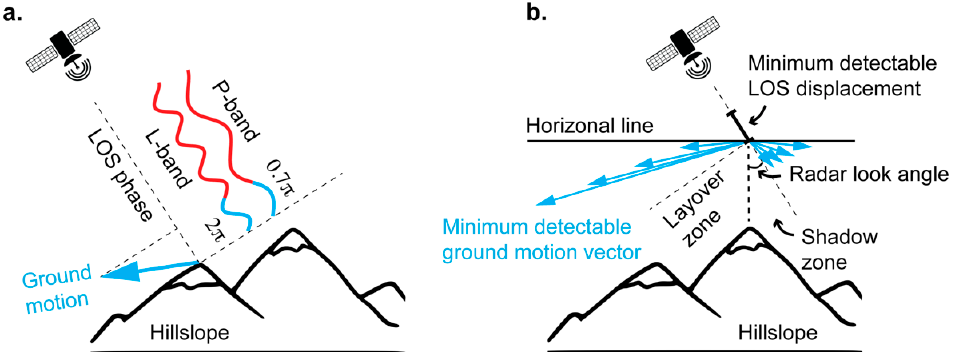
Figure 5. Sensitivity of radar sensors to ground deformation. ( a ) Sensitivity difference owing to radar frequency bands. ( b ) A sketch of minimum detectable ground displacement owing to radar look angle and dip angle of ground motion.